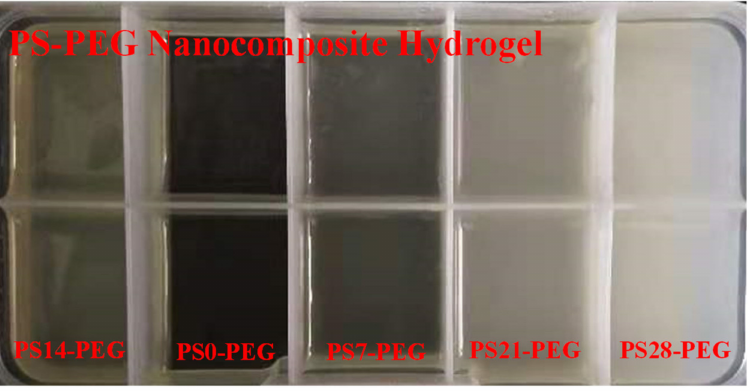
Figure 9. Morphology of PS-PEG